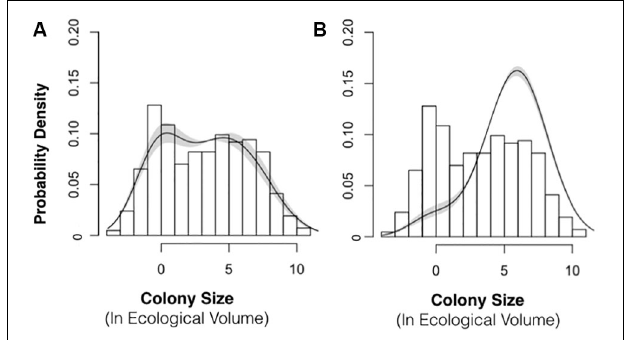
FIGURE 8 | Population Density Distribution with Best-Fit Model Stable Size Distribution. The best-fit model (lines) for the stable size distribution is shown next to the empirical size distribution (bars) of P. divaricata for 2015 (A) and 2016 (B) . The shading depicts 95% confidence intervals. This best-fit model of the size distribution was incorporated into the IPM models for 2015–2016 and